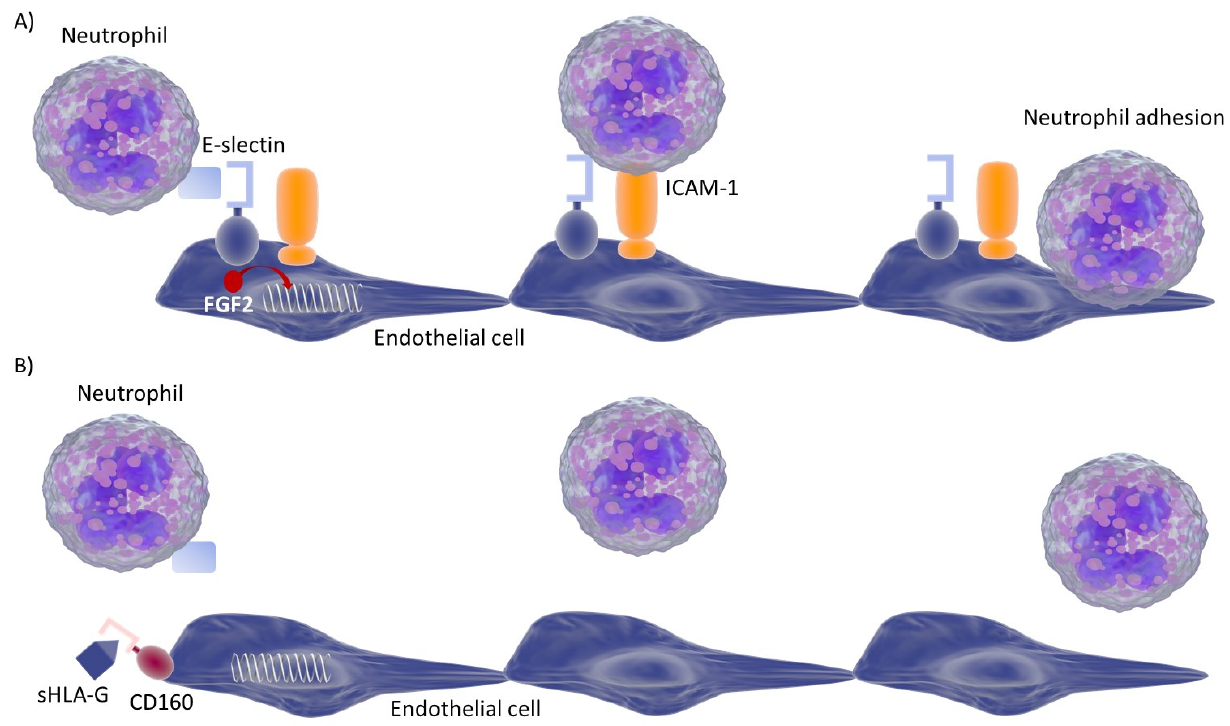
Figure 4. Representation of the molecular interaction on the basis of neutrophil cell adhesion to endothelial cells. ( A ) Neutrophils interact with E-selectin, enhancing ICAM-1 recognition and adhesion to endothelial cells. Both these molecules are induced by FGF2 (fibroblast growth factor 2). ( B ) In the presence of COVID-19 there is an increase in sHLA-G molecules interacting with CD160, which inhibits FGF2-dependent induction of E-selectin and ICAM-1. The reduction of E-selectin and ICAM-1 expression reduces neutrophil adhesion to endothelial cells. This condition might improve clinical conditions, reducing neutrophils